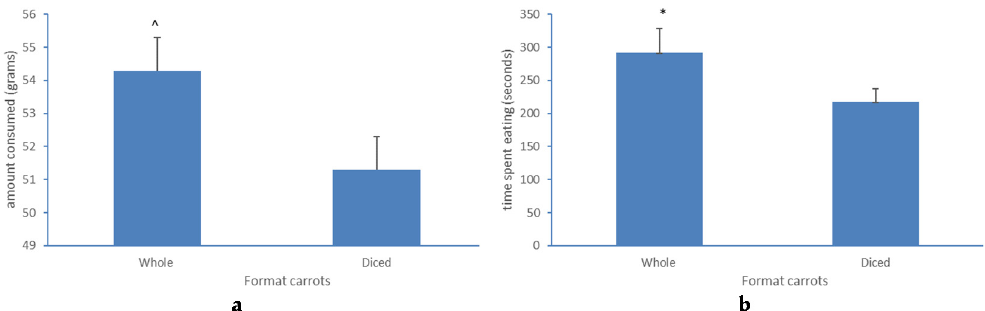
Figure 2. ( a ) panel-time (mean ± SEM) children spent eating carrots in seconds. ( b ) panel-amount children consumed (mean ± SEM) during 10 min. Shown for children who finished their consumption of whole and diced carrots before the 10 min time limit n = 36. * p < 0.05, ^ p = 0.06.